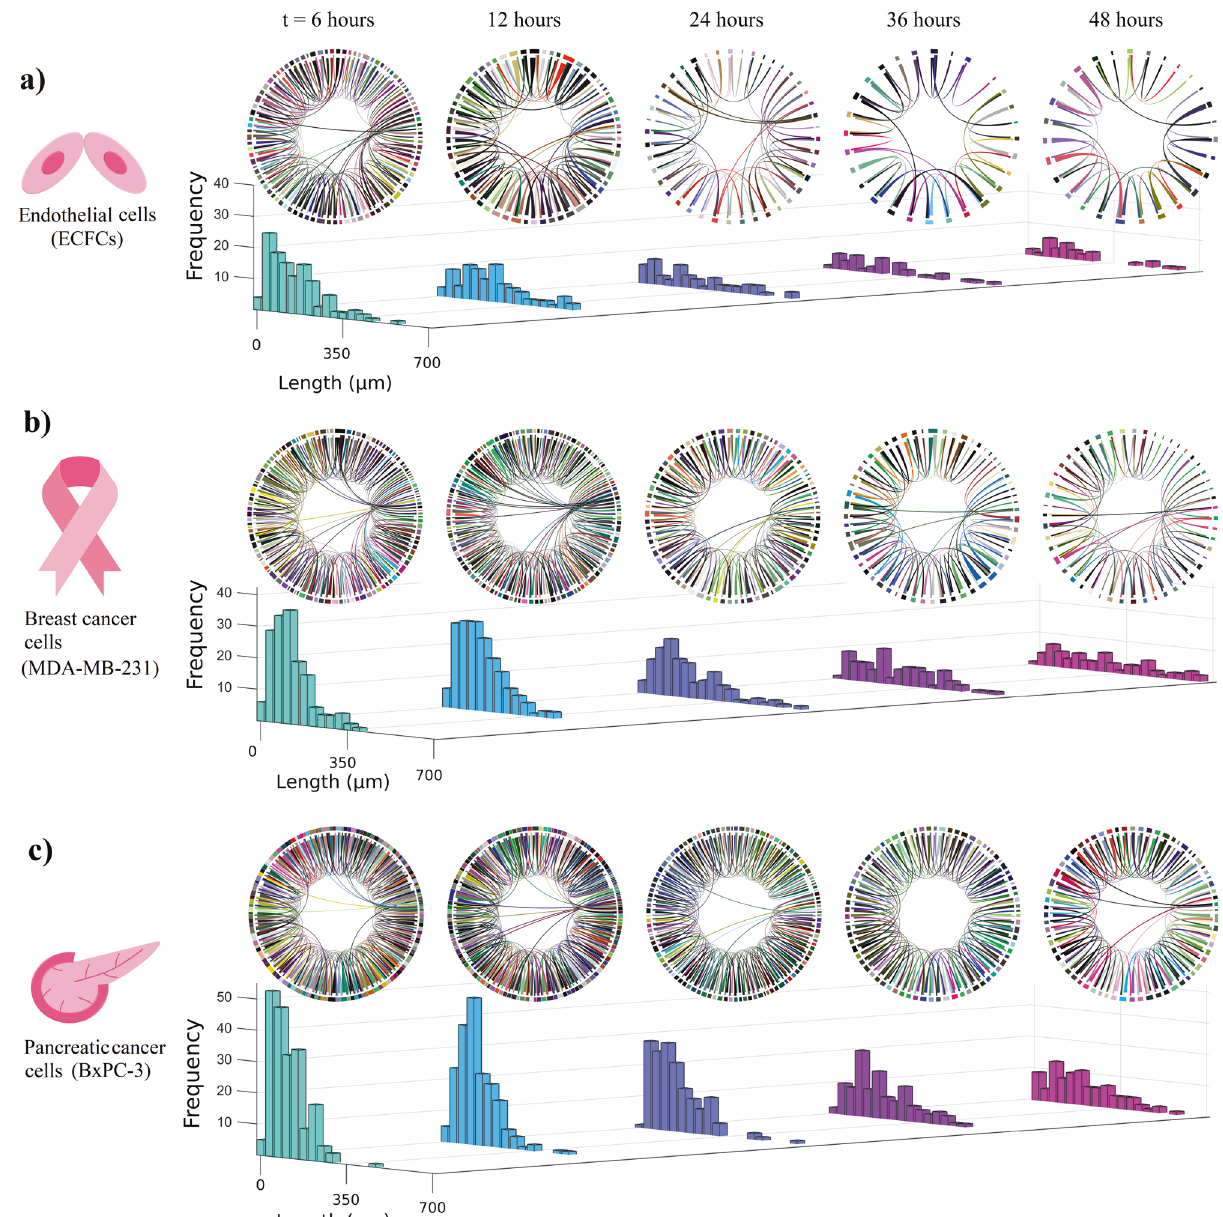
Fig. 2 Circular layouts of network growth and distribution of edge lengths. a Circular layout of EC network growth determined from the videos of fi ve independent experiments using the EC cells with the average taken over time. The corresponding histograms in the lower panel suggest there are a substantial number of small edges in early stages but the edge lengths increase over time. b A similar analysis for the breast cancer cell VM network determined from the videos of fi ve independent experiments. c The histograms for pancreatic cancer cell VM network showing the total number of edges over time. Histograms are plotted from fi ve individual pancreatic cancer the purple dashed line suggesting that the ECFCs network is small-world in 48 h (Fig. 3c). The number of vertices and edges in the MDA-MB-231 breast cancer cell line network attains its maximum after ~10 h. The decay rate of C is greater that L in the breast cancer network, and this proportion causes a decrease in the small-worldness factor (Fig. 3d). The maximum number of vertices and edges grows faster for the BxPC-3 pancreatic cancer cell line. The exponential decrease in C leads to an exponential decreased trend in σ (Fig. 3e). Our observations suggest that although the angiogenesis network formed by ECFCs is less stable than both the cancer cell line VM (MDA-MB-231 and BxPC-3 cells), the neighbours of any given node are likely to be